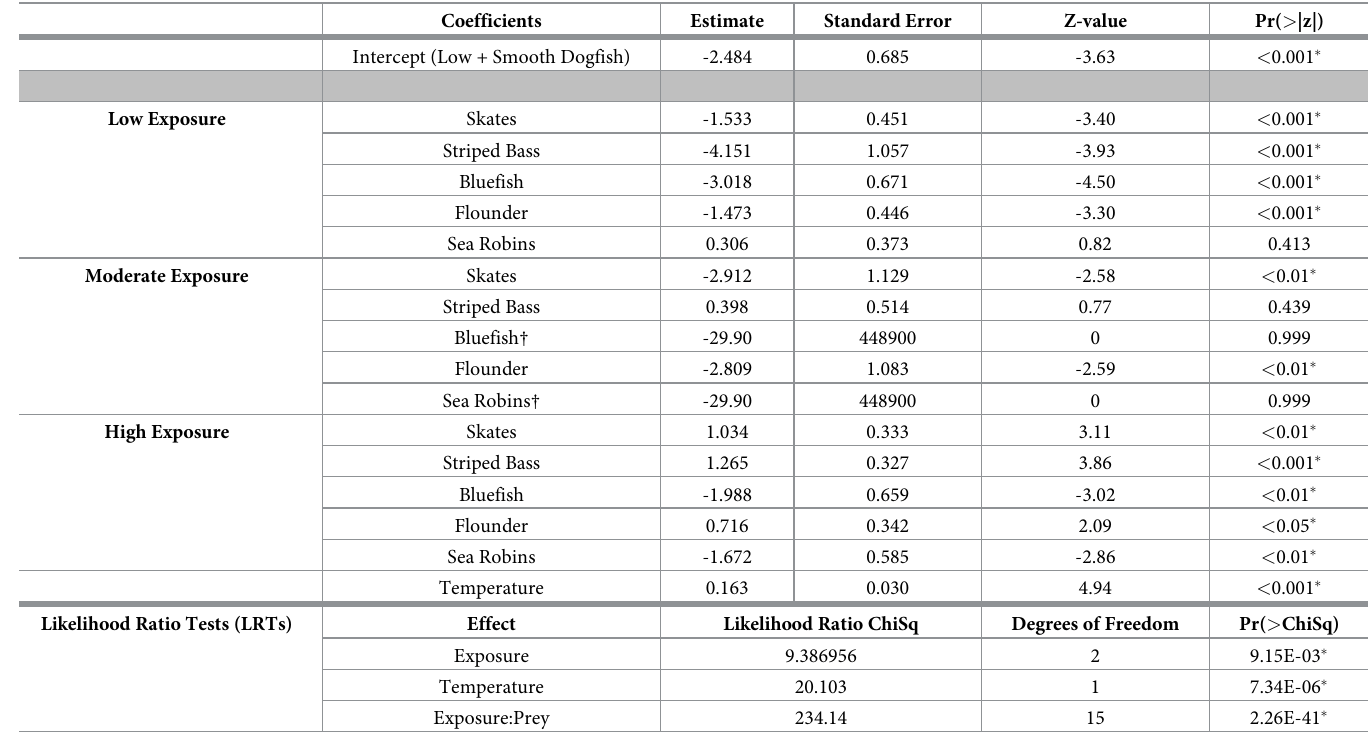
Table 1. Effects of shark exposure on relative abundance of prey